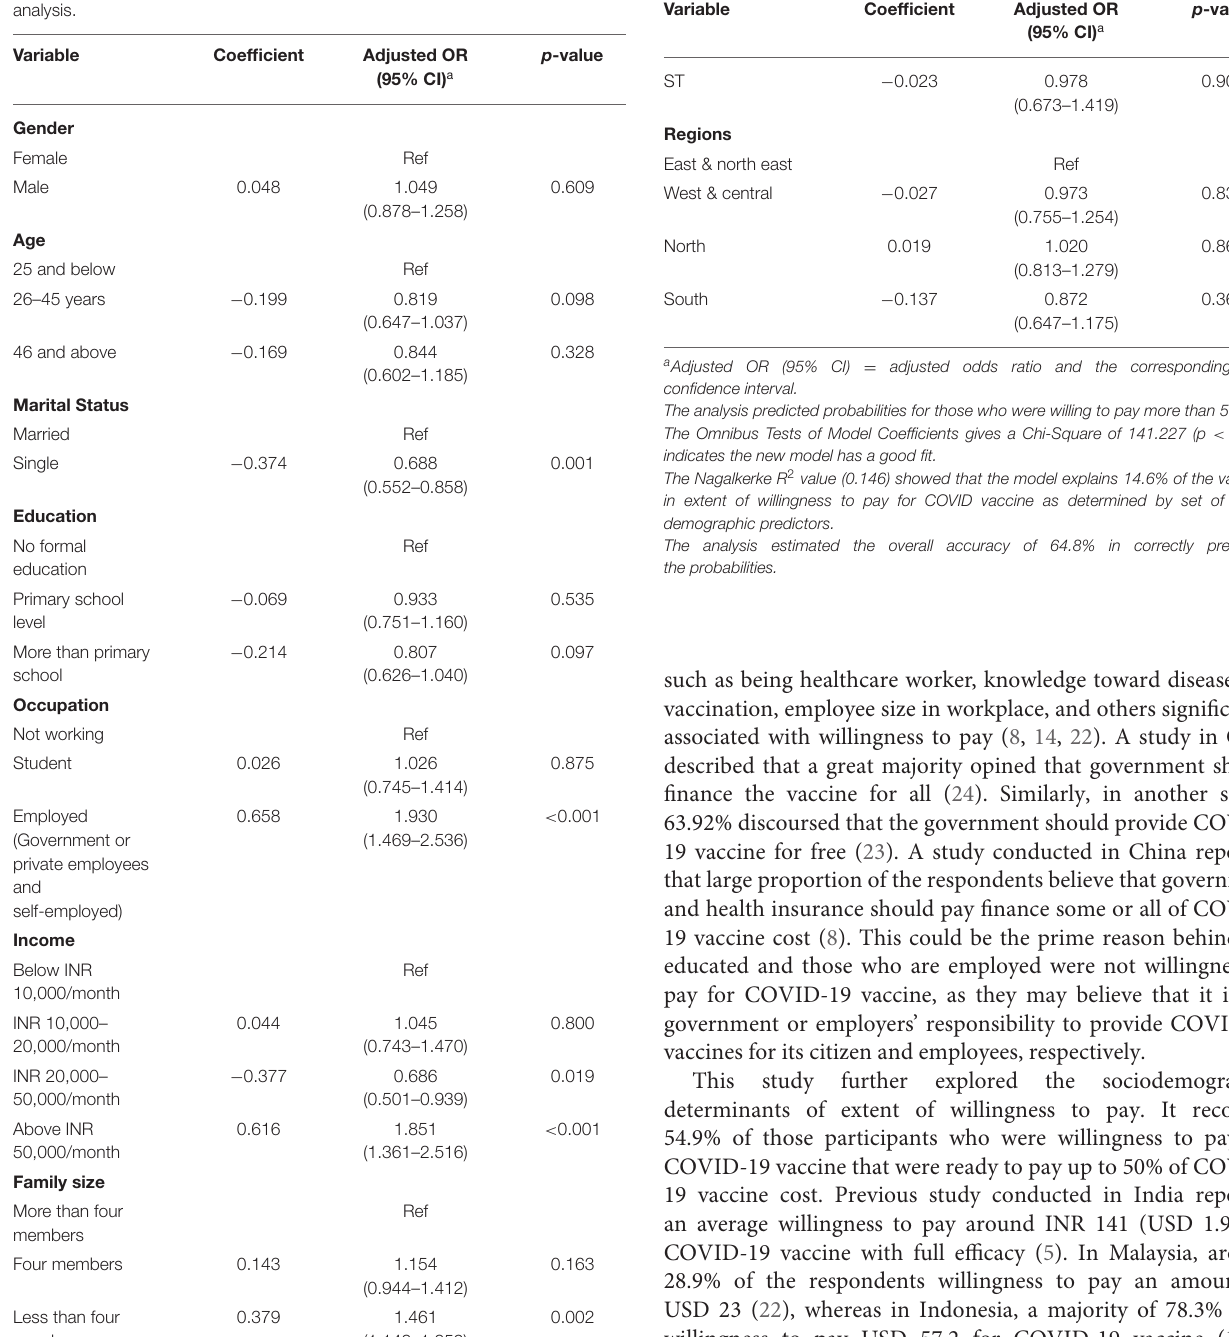
TABLE 5 | Association between the sociodemographic variables and extent of willingness to pay ( n = 2,271) using the multivariate binary logistic regression